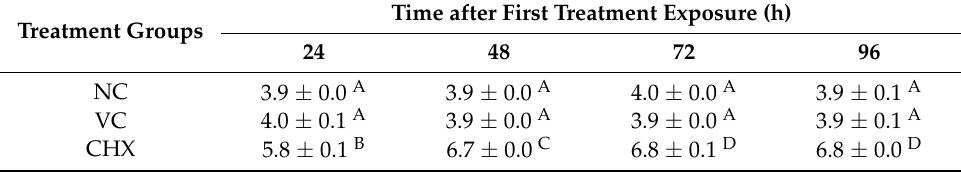
Table 1. Effect of the chlorhexidine-based chitosan formulation (CHX) on the pH of the S. mutans biofilms at 24, 48, 72 and 96